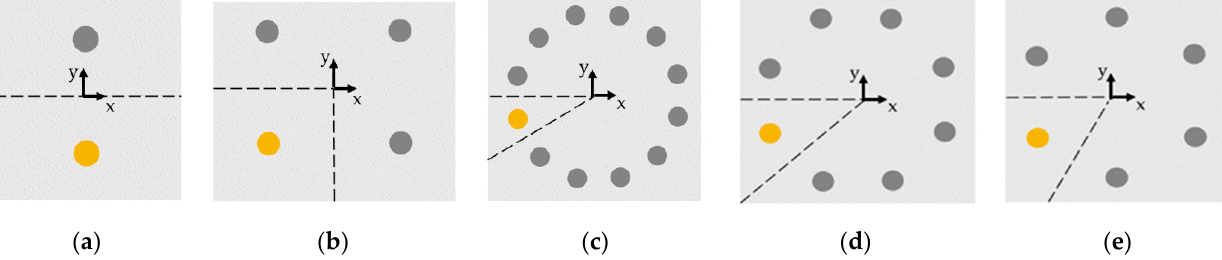
Figure 2. Plane view of a WEC (wave energy converter) in front of a V-shaped breakwater, using the method of images, for various forming angles θ : ( a ) θ = 180 degrees; ( b ) θ = 90 degrees; ( c ) θ = 30 degrees; ( d ) θ = 45 degrees; ( e ) θ = 60 degrees. The image converters are denoted in dark grey and the breakwater as a dashed line.